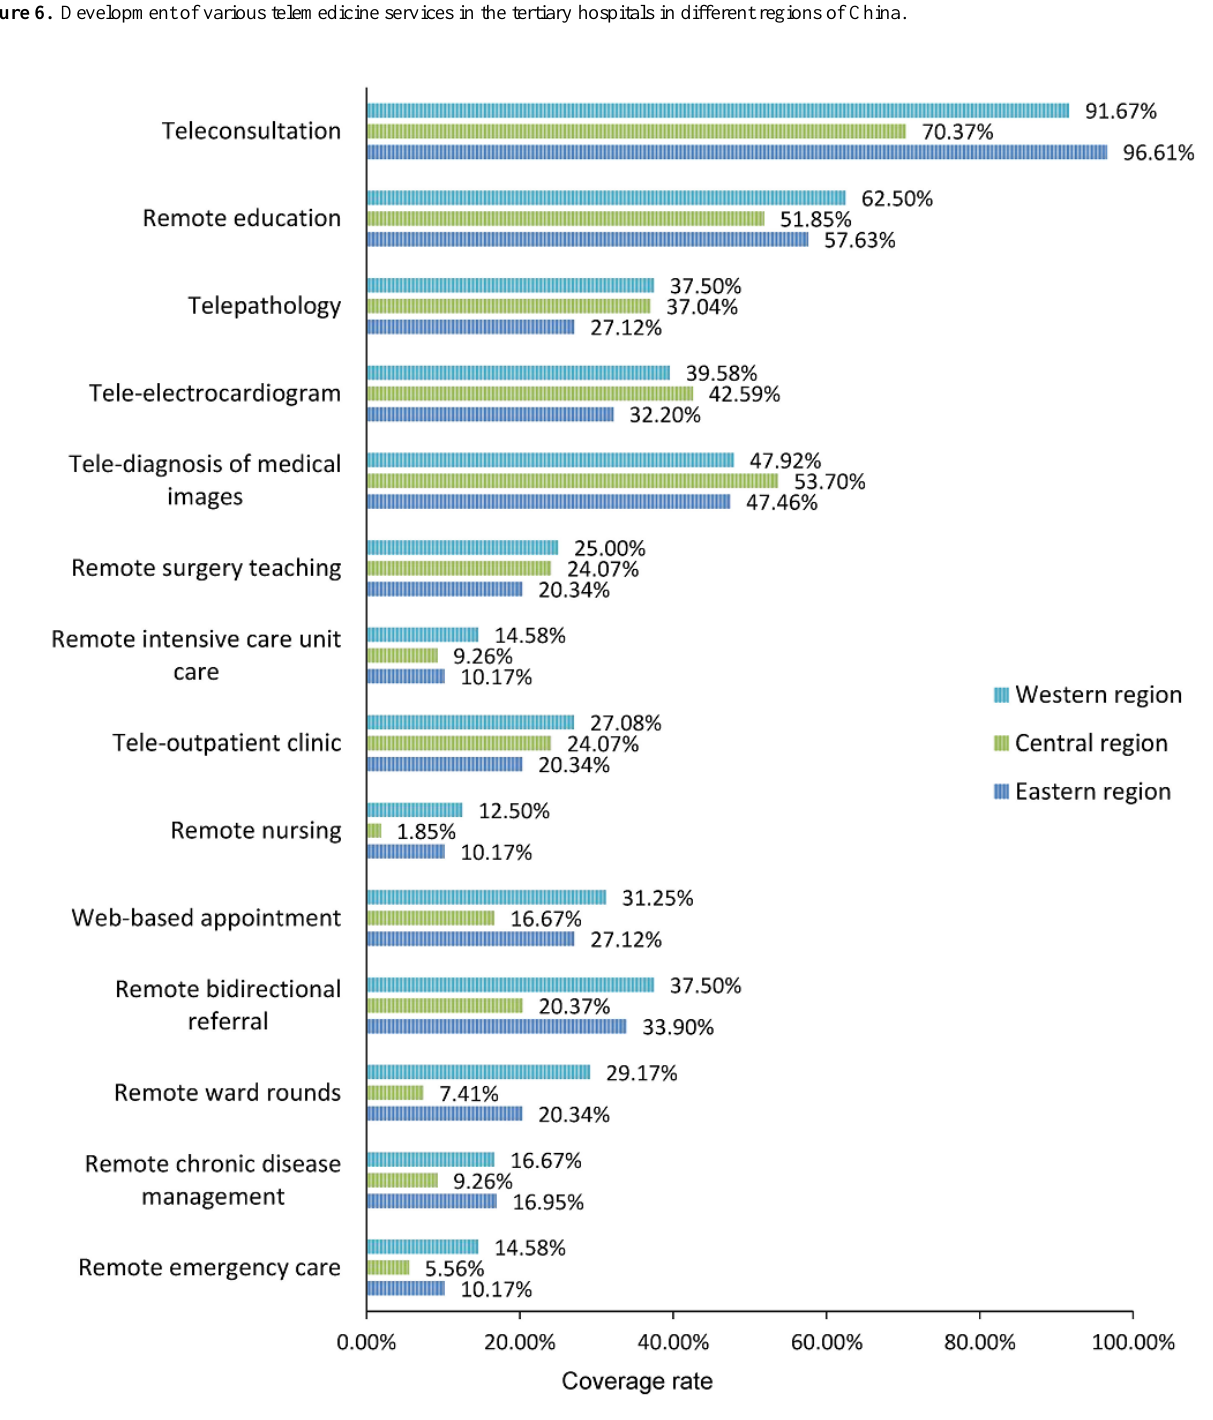
Figure 6. Development of various telemedicine services in the tertiary hospitals in different regions of